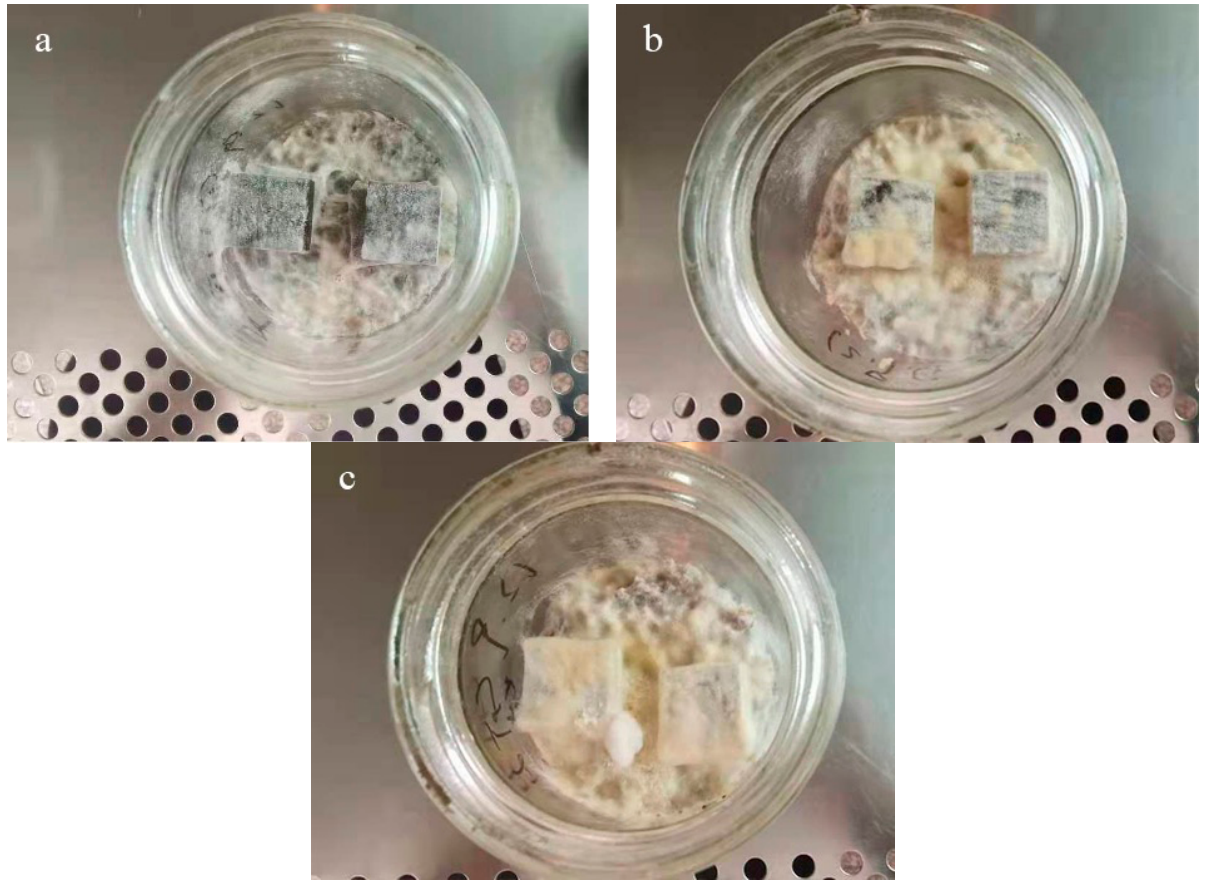
Figure 6. ( a ) Dried blocks soaked in sterile fermentative liquid after 12 weeks. ( b ) Undried blocks soaked in sterile fermentative liquid after 12 weeks. ( c ) Blocks not soaked in sterile fermentative liquid after 12 weeks.